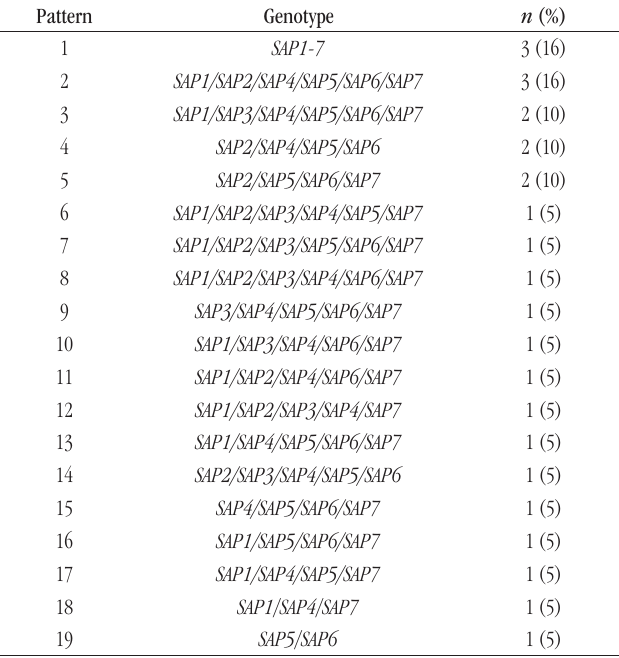
taBLE 3 − Genotypic patterns identified in vaginal isolates of C. albicans Pattern